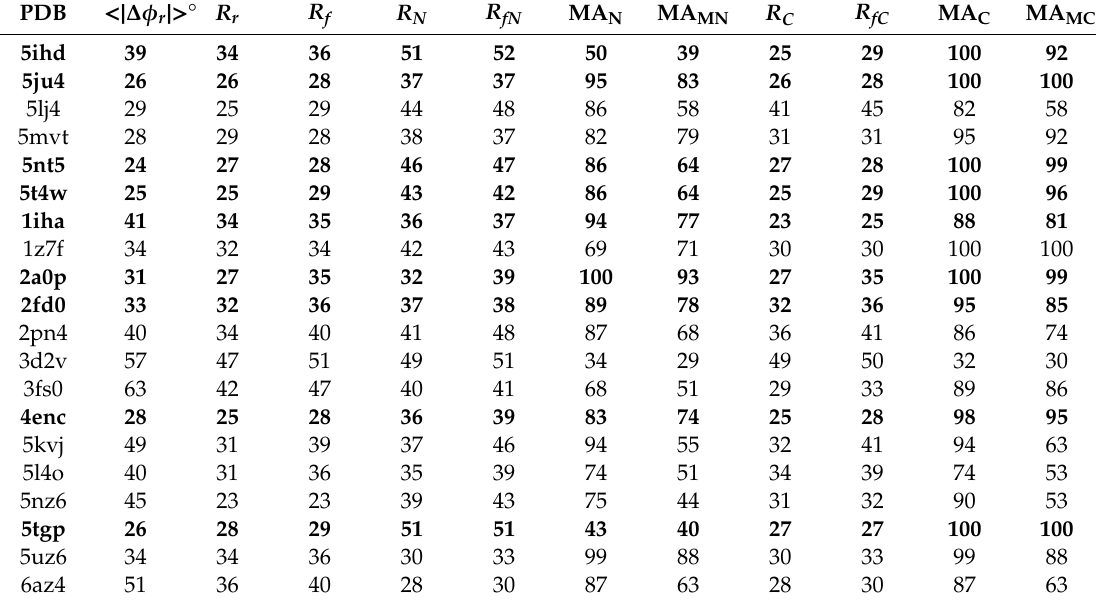
Table 2 suggests the following